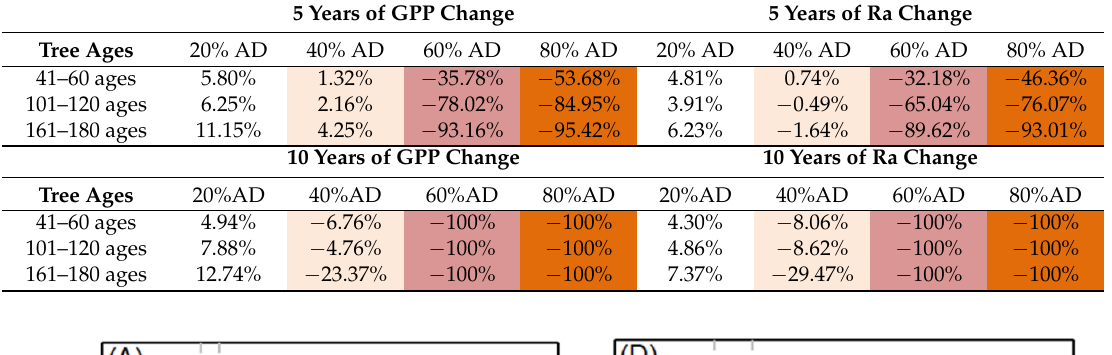
Table 4. Simulated total changes of GPP and Ra at 5 years and 10 years after the beginning of an outbreak compared to no defoliation (control) in the balsam fir forest. AD denotes annual defoliation. 5 Years of GPP Change 5 Years of Ra Change Tree Ages